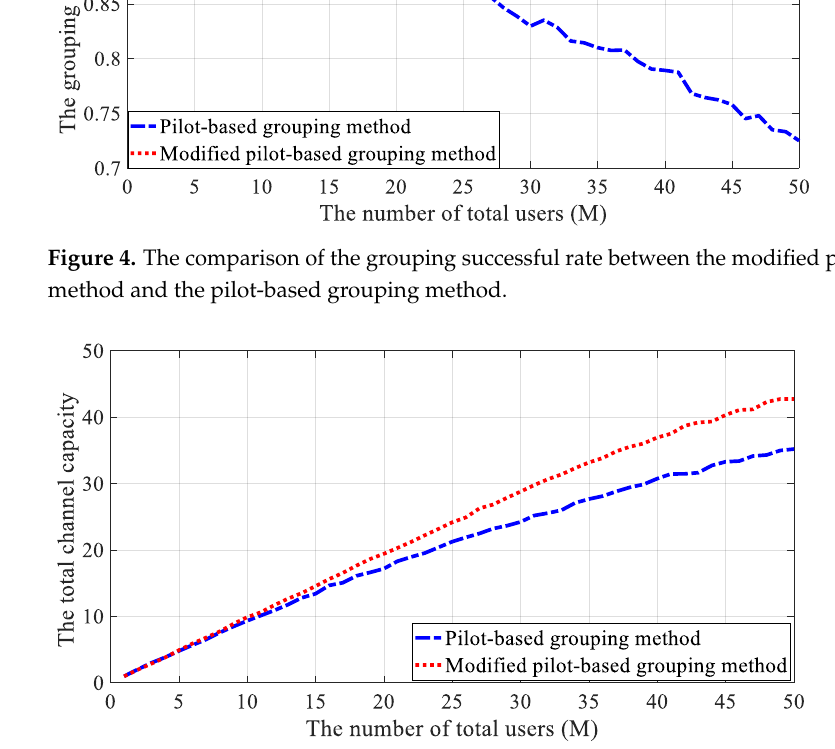
Figure 5. The comparison of the total system channel capacity between the modified pilot-based grouping method and the pilot-based grouping method.